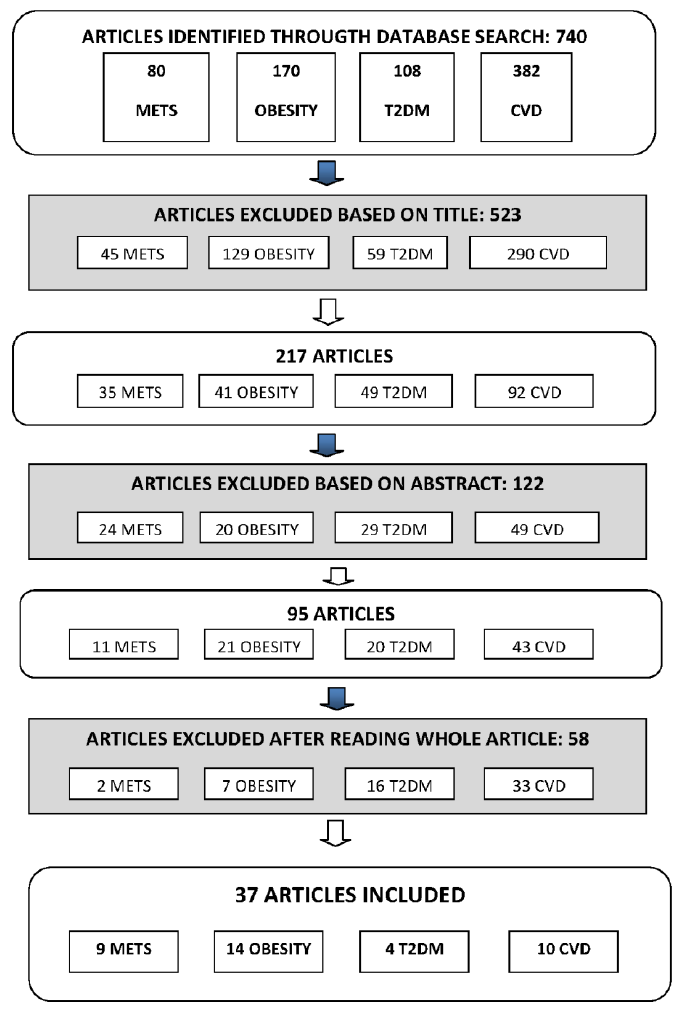
Figure 1. Flow-chart of the selection process. Abbreviations are as follows: METS, metabolic syndrome; T2DM, type 2 diabetes mellitus; CVD, cardiovascular